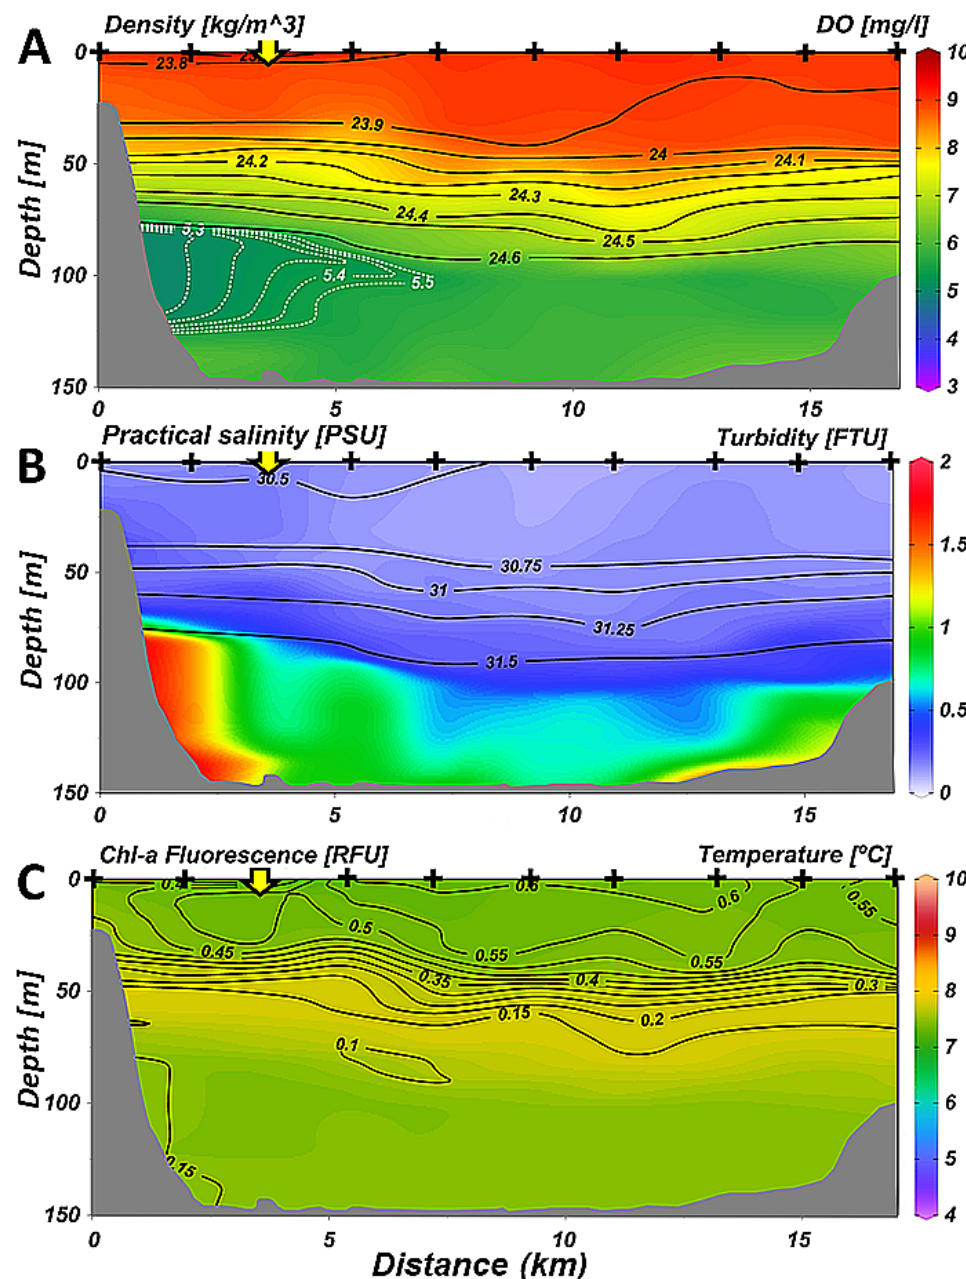
Figure 7. Along-bay section of ( A ) DO (in gradient color and white dotted isolines) and density anomaly (black isolines); ( B ) turbidity (in gradient color) and salinity (black isolines); and ( C ) temperature (in gradient color) and Chl-a fluorescence (black isolines) for April 2018. The intersection between cross-bay and along-bay sections is marked with a yellow arrow.